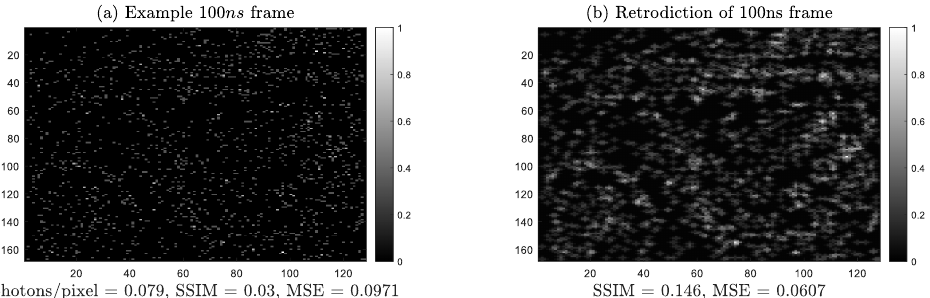
Figure 4. ( a ) An example of a single 100 ns frame of the test target image. ( b ) The Bayesian Retrodiction of the image shown in ( a ). Both images are normalised to their maximum